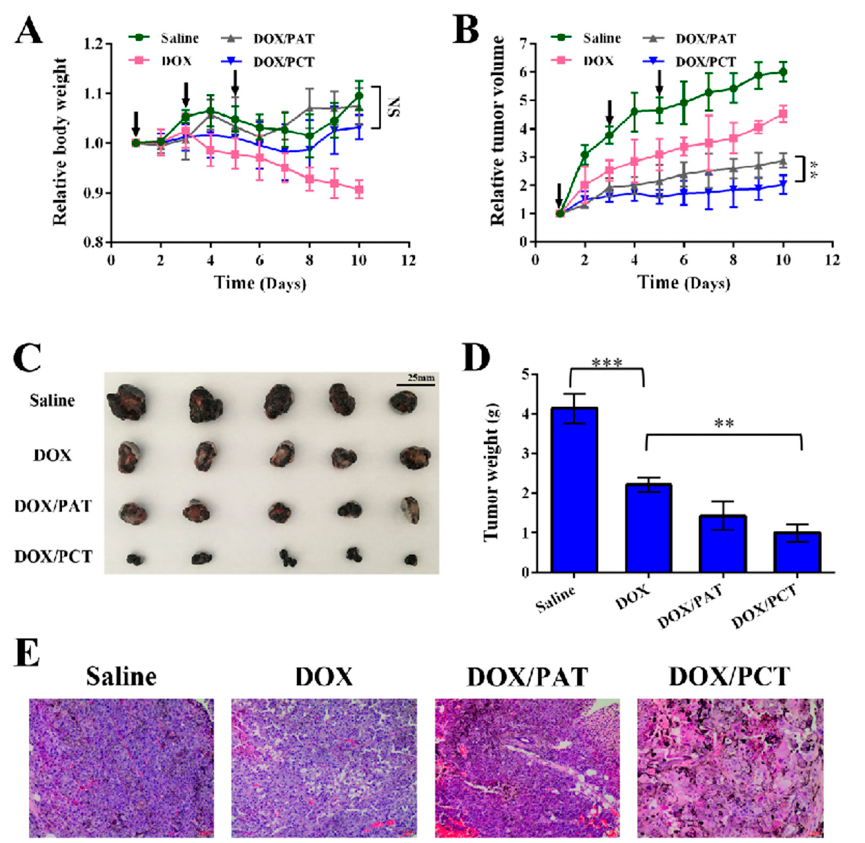
Figure 8. ( A ) The changes in body weight and ( B ) tumor volume of saline-, free DOX-, DOX/PAT-, and DOX/PCT-injected B16 tumor-bearing mice. ( C ) The pictures of excised tumor tissues and ( D ) tumor weight of different groups from mice after being sacrificed (mean ± SD, n = 5). ( E ) H&E staining results of tumors in different groups of BALB/c nude mice, (The bar is 40 μ m). NS means p > 0.05 (not significant), ** means p < 0.01 (moderately significant) and means *** p < 0.001 (highly significant).